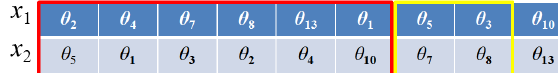
Figure 2. Feature similarity based on relaxation window in residual sequences of matched keypoint pairs. The red and the yellow rectangle present the baseline window and the relaxation window, respectively. The similarity will reach the maximum value when the window size is equal to 8, since the overlapping models within the window are { θ 1 , θ 2 , θ 3 , θ 4 θ 5 , θ 7 , θ 8 } .